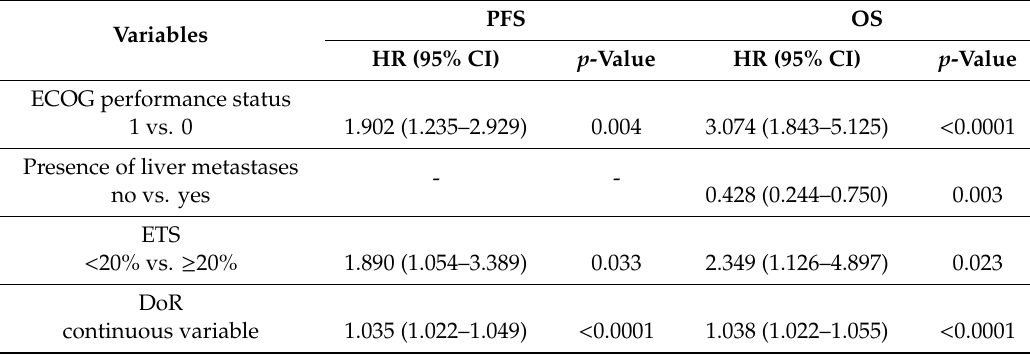
Figure 4. Progression-free survival ( a ) and overall survival ( b ) curves according to DoR ≥ vs. < median value in FOLFOXIRI and GemNab groups. Table 5. Multivariate